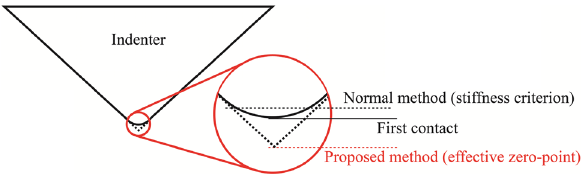
Figure 1. Difference in zero-point determination between the normal (stiffness criterion) and proposed